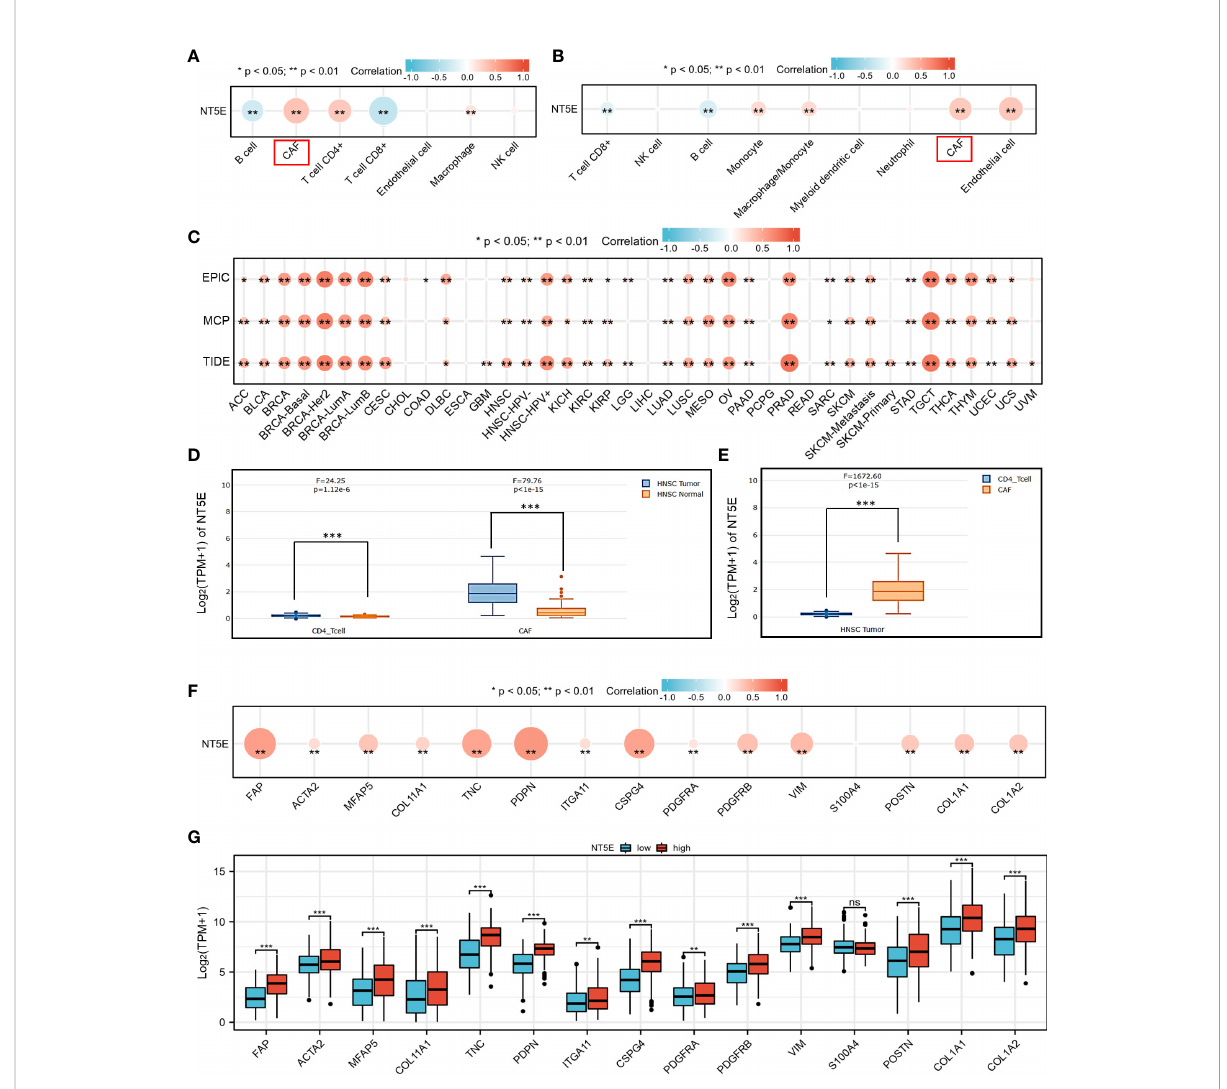
FIGURE 5 NT5E expression level was associated with unique immune in fi ltration in HNSC. (A) Correlation between NT5E expression and EPIC score of various immune cells. (B) Correlation between NT5E expression and MCP-counter score of various immune cells. (C) Correlation between NT5E expression and CAF based on TIMER2.0 database. (D) NT5E expression patterns of CAF and CD4 + T cell based on the GEPIA2021 database. (E) Comparison of NT5E expression analysis between CAF and CD4 + T cell in HNSC based on the GEPIA2021 database. (F) Correlation between NT5E expression and CAF-related markers. (G) Comparison of CAF-related markers between NT5E-high and NT5E-low groups. (ns, p ≥ 0.05, * p < 0.05, ** p < 0.01, *** p <